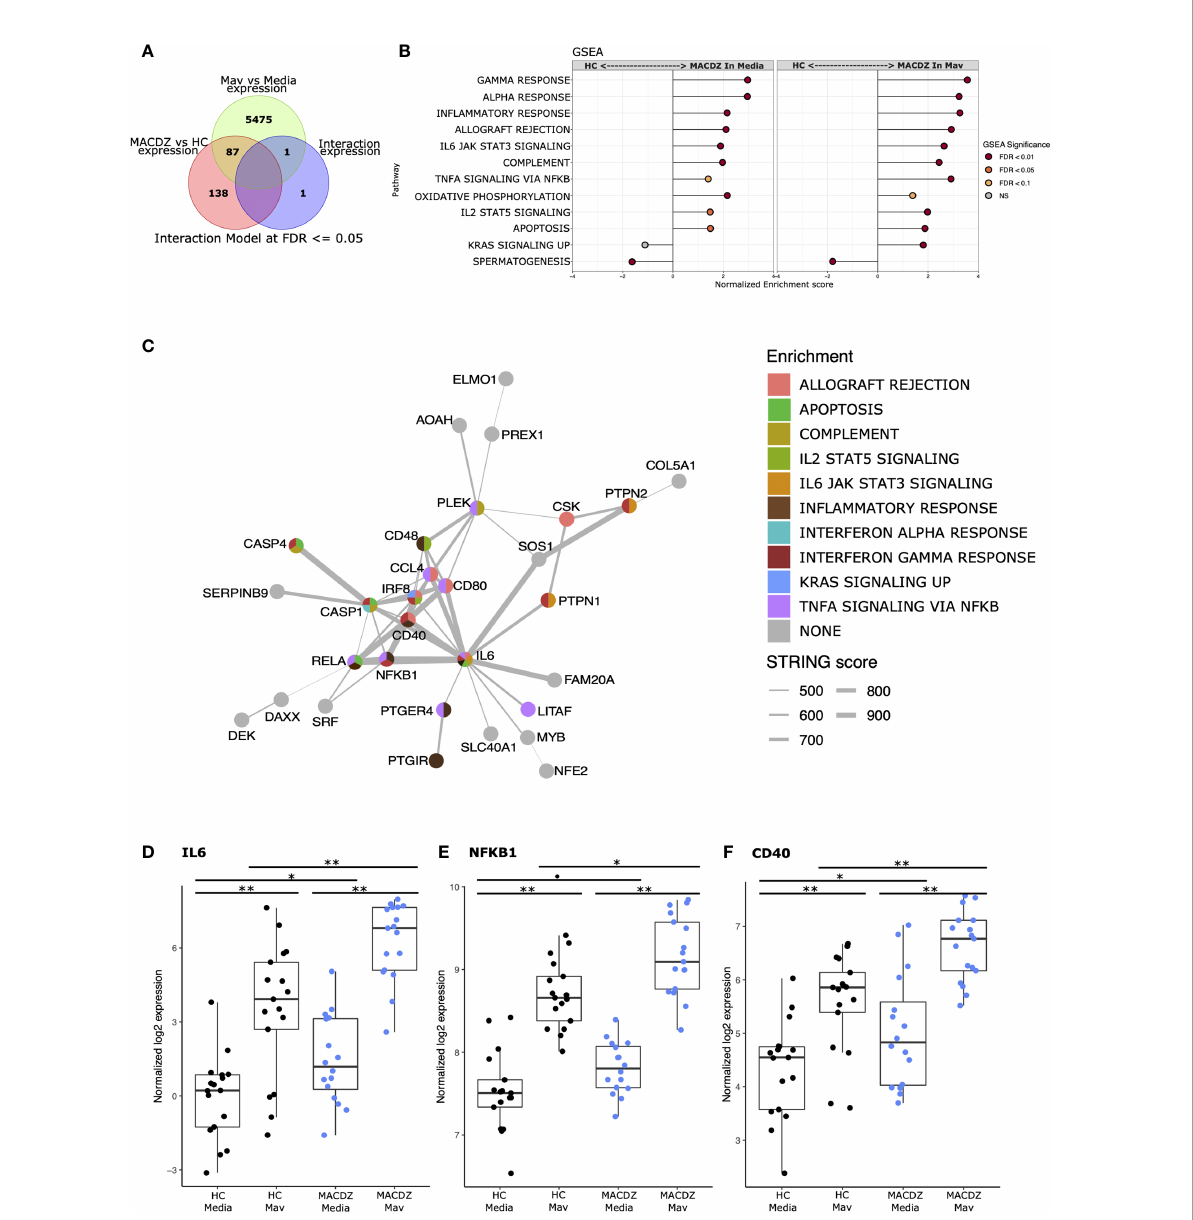
FIGURE 4 Monocyte response to Mycobacterium avium infection in MACDZ versus HC subjects. RNASeq transcriptional pro fi les were measured from monocytes isolated from MACDZ subjects (N = 17) or healthy controls (N = 17) with a media only condition or after infection with M. avium (MOI = 5) for 6 hrs. (A) Expression pro fi les were compared between MACDZ and HC subjects with and without Mav infection using a linear model with an interaction term. Venn diagram depicts 227 differentially expressed genes (DEGs) distinguishing MACDZ vs HC subjects included 138 Mav-independent DEG signi fi cant for MACDZ alone, 87 for both MACDZ and Mav, and 2 for the interaction term, together de fi ned as Mav- dependent DEG (FDR <0.05). (B) Gene set enrichment analysis (GSEA) with Hallmark terms comparing MACDZ vs HC subjects within media or Mav infection conditions. (C) STRING network analysis of 89 Mav-dependent DEGs (87 Mav plus 2 from the interaction term) which differentiate MACDZ vs HC subjects. Circles depict genes and are colored by membership in Hallmark mSigDB gene sets. Grey lines depict annotated connection between 2 genes in the STRING database with line thickness proportionate to the score. (D – F) Boxplots depicting voom normalized log2 mRNA expression values in MACDZ versus HC subjects with and without Mav infection. FDR values depict comparison of MACDZ vs HC media expression, MACDZ vs HC Mav expression, and Mav vs media for MACDZ or HC subjects (FDR ≤ 0.1 shown by *, FDR ≤ 0.05 shown by *, and FDR ≤ 0.01 shown by **). Median and interquartile range